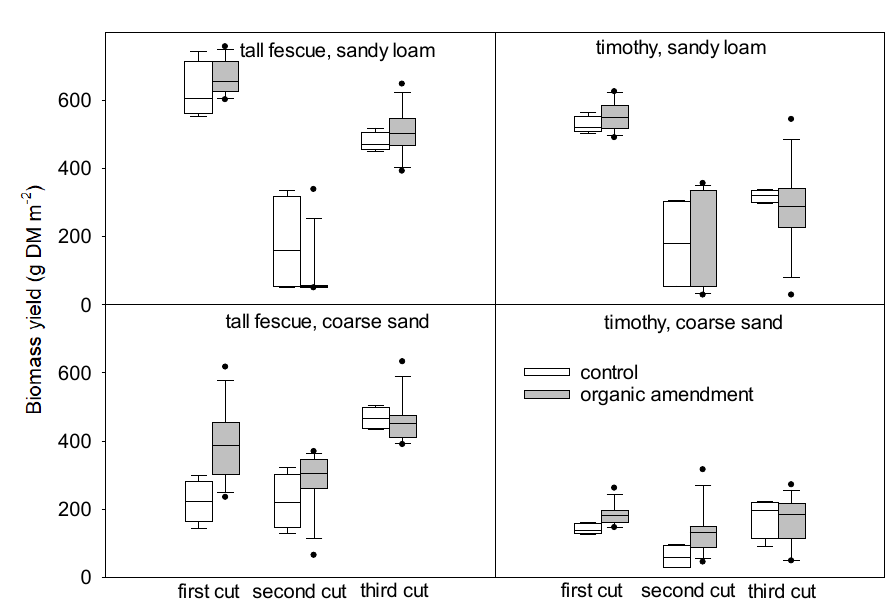
Fig. 2. Mean yield in the organic amendment treatments in comparison with the control treatment for the three cuts in 2018 at Særheim, Norway